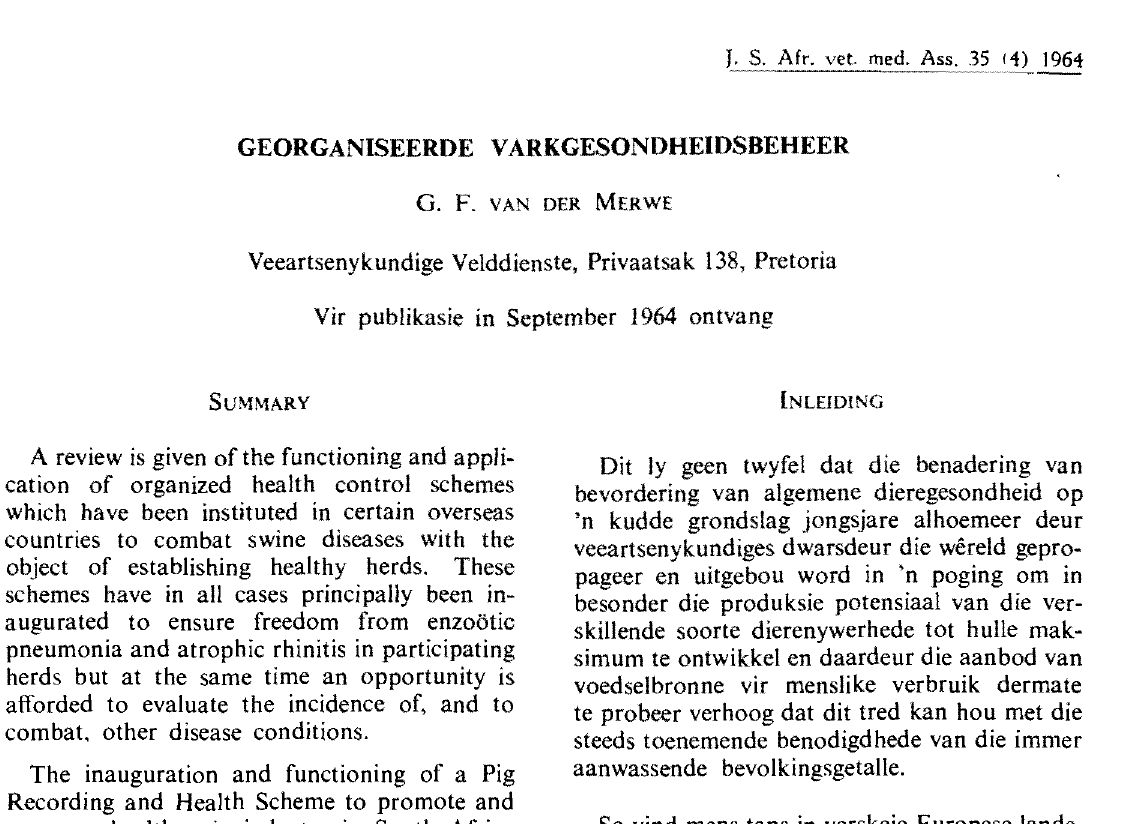
n Oorsig word gegee van die